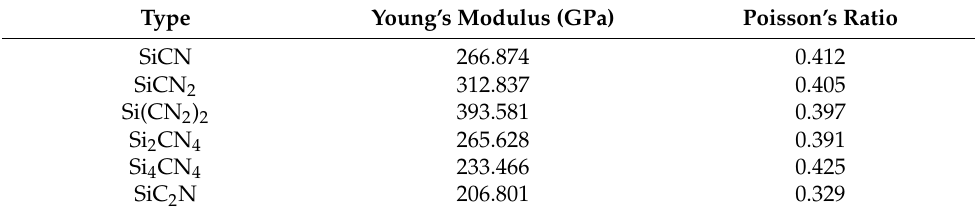
Table 2. Young’s modulus, and Poisson’s ratio of a-SiC x N y